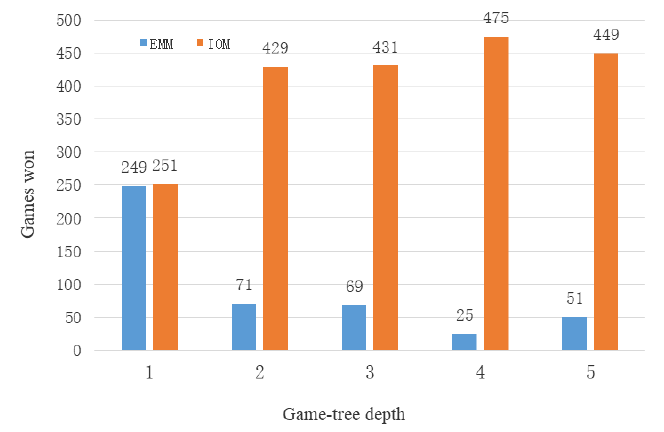
Figure 11. The experimental results for IOM vs. EMM in chess.